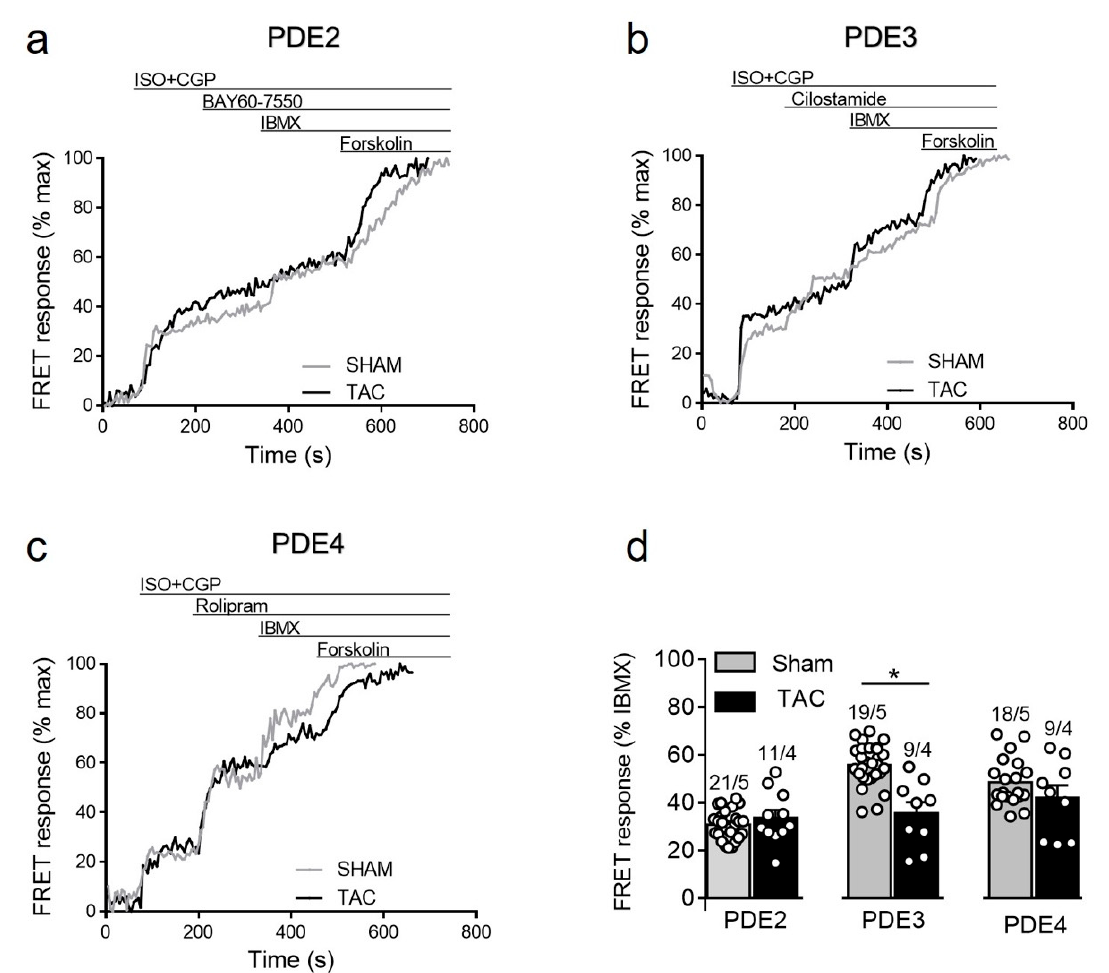
Figure 6. cAMP responses to selective PDE2, PDE3 and PDE4 inhibition after β 2 -AR stimulation in sham and TAC myocytes. Representative FRET ratio traces recorded from cells in response to β 2 -AR stimulation with 100 nmol/L ISO in the presence 100 nmol/L CGP20712A (ISO+CGP), followed by ( a ) 100 nmol/L of the PDE2 inhibitor BAY60-7550, ( b ) 10 µmol/L of the PDE3 inhibitor cilostamide, and ( c ) 10 µmol/L of the PDE4 inhibitor rolipram. PDE inhibitor responses were calculated as a% maximal PDE inhibition by IBMX (100 µmol/L). Forskolin (10 µmol/L) was applied at the end of each experiments to obtain the maximal FRET response. ( d ) Quantification of PDE inhibitor responses in sham and TAC myocytes. Means ± SE. Number of cells/mice are stated above the bars. * p < 0.05 by mixed ANOVA followed by Wald’s chi-squared test.